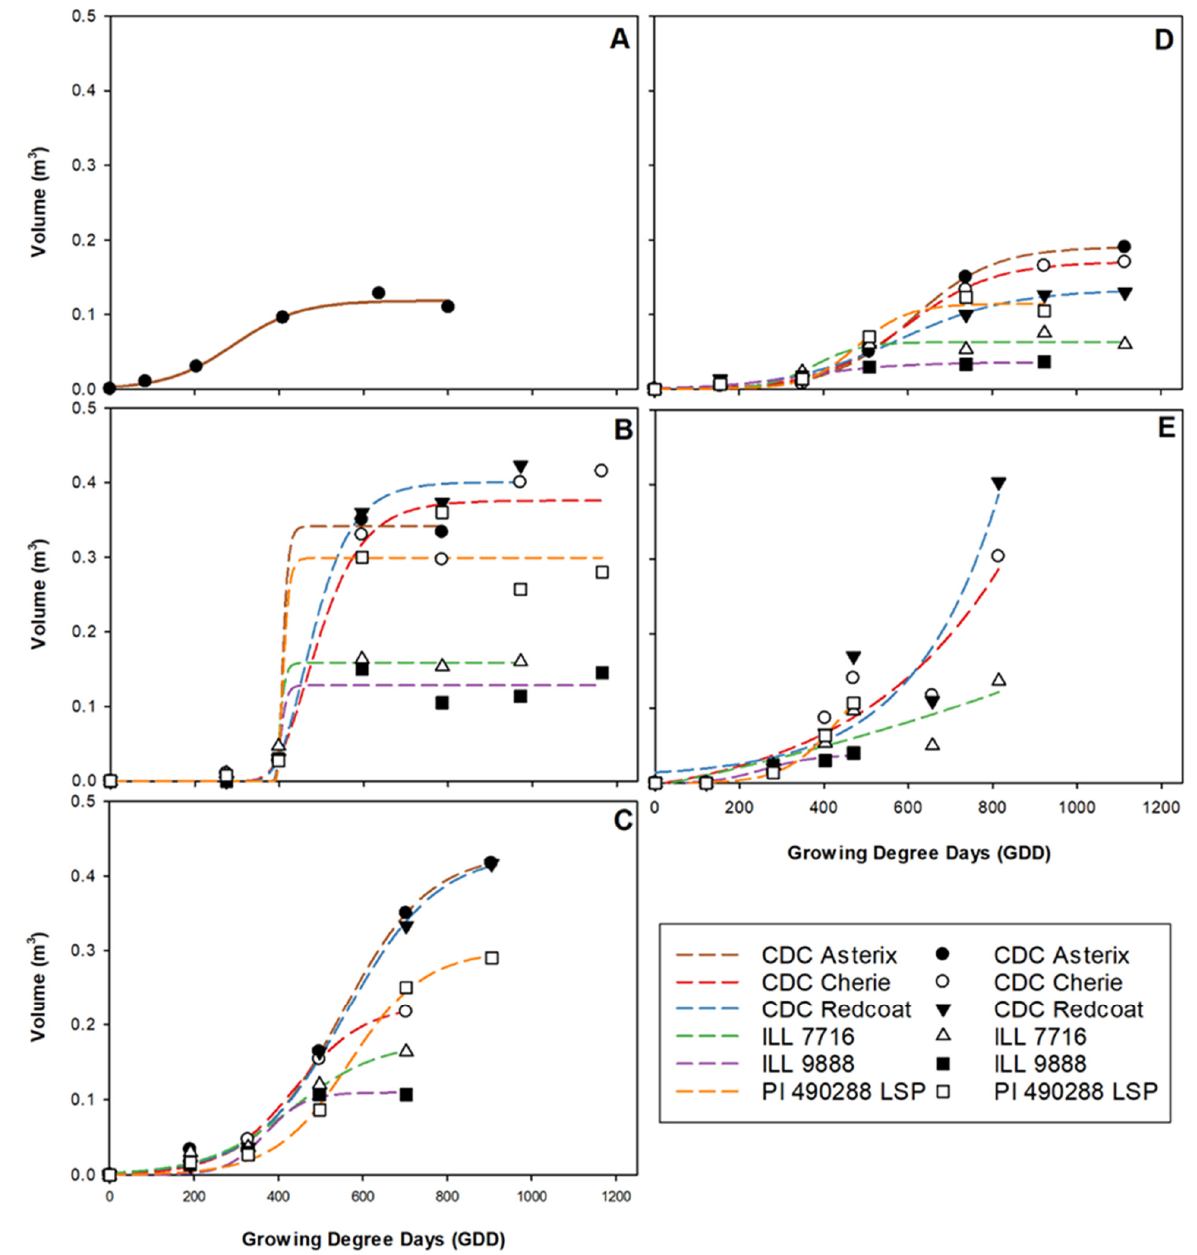
Figure 6. Three-parameter growth curves showing volume accumulation for each genotype throughout the growing season at each site-year; Nasser 2017 ( A ), Rosthern 2017 ( B ), Sutherland 2017 ( C ), Nasser 2018 ( D ), and Rosthern 2018 ( E ). Data at Nasser 2017 was best described by combing all genotypes within the model.